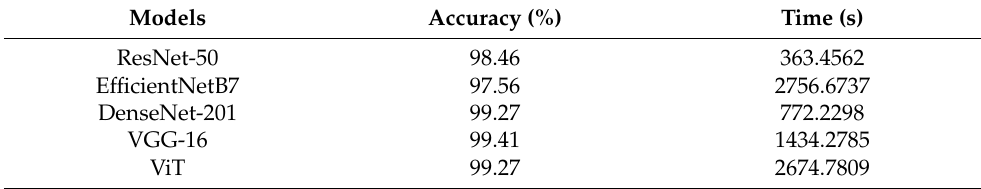
Table 1. Experimental results of the pre-trained models on the CASIA-B dataset.